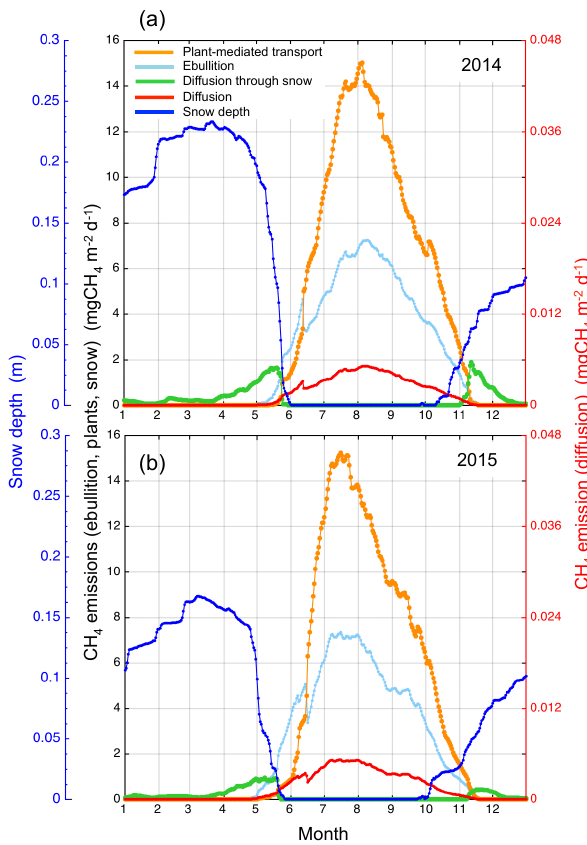
Figure 9. Year-round mean simulated CH 4 emissions of the model domain through different pathways and domain mean snow depth for (a) 2014 and (b)